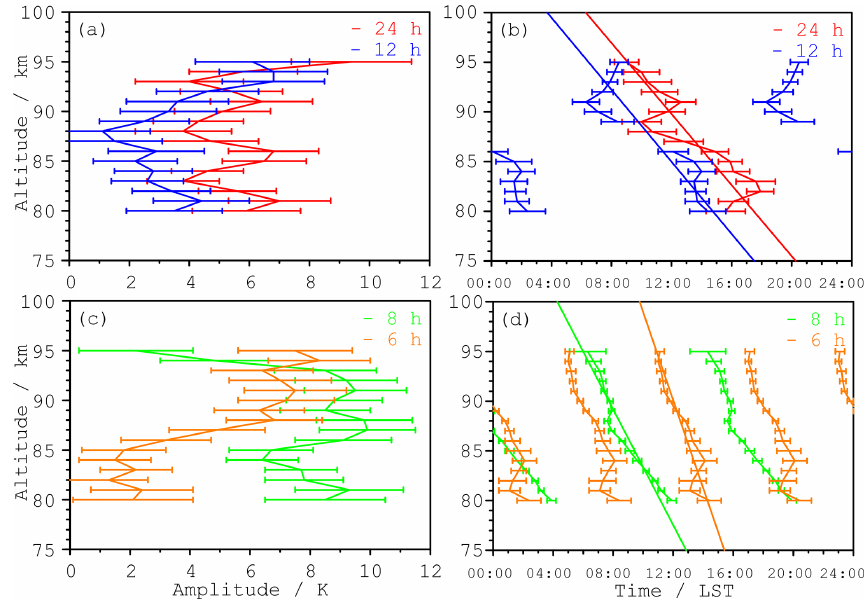
Figure 6. Amplitudes (a, c) and phases (b, d) of the 24h (red), 12h (blue), 8h (green), and 6h (orange) wave components during the 24h period around the WADIS-2 launch. The phase shift with altitude is approximated with straight lines and used to calculate vertical wavelengths. The approximation corresponds to vertical wavelength of 43km for the 24h, 22km for the 12h, 23km for the 8h, and 30km for the 6h component.